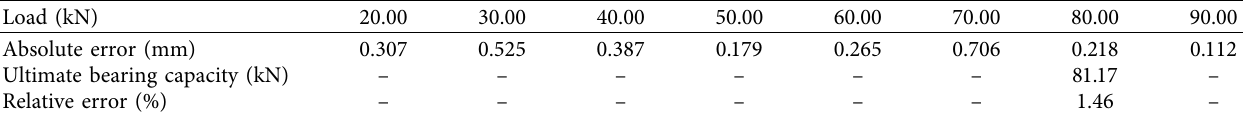
Table 7: Analysis of the field test and theoretical